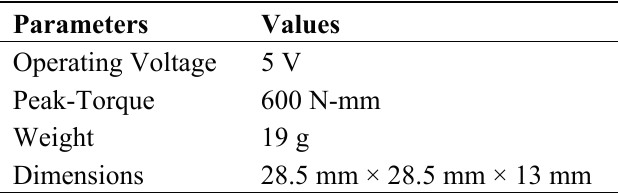
Figure 5. CAD model of Volz DA 13-05-60 servo actuator [16]. Table 4. The specifications of Volz DA 13-05-60 servo actuator [16].